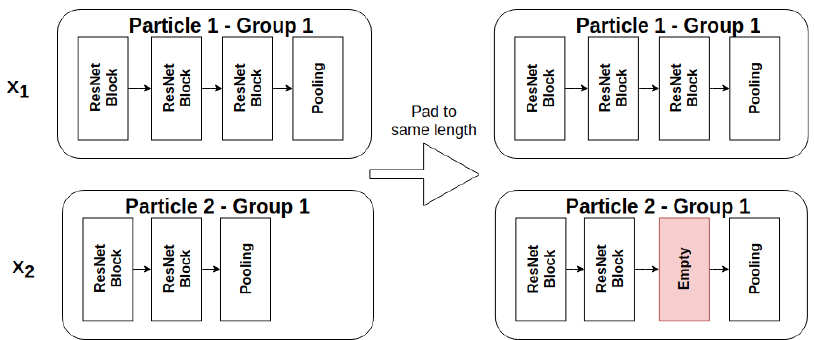
Figure 4. Groups from particles X 1 and X 2 which are temporarily padded to the same length in preparation for the particle difference